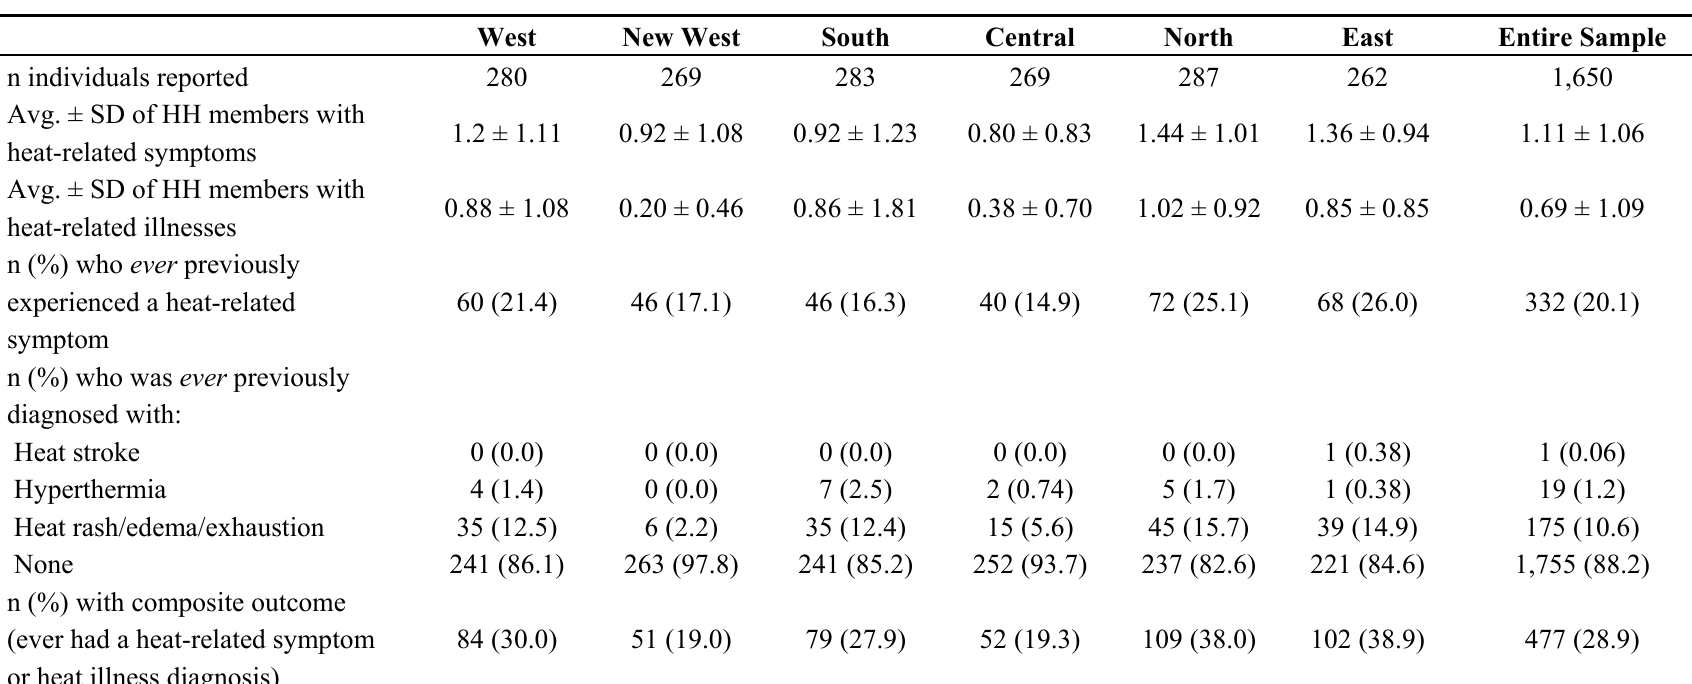
Table 2. Prevalence of self-reported outcomes within individuals (N = 1,650) residing in Ahmedabad slums across six city zones within the sampled population. West New West South Central North East Entire